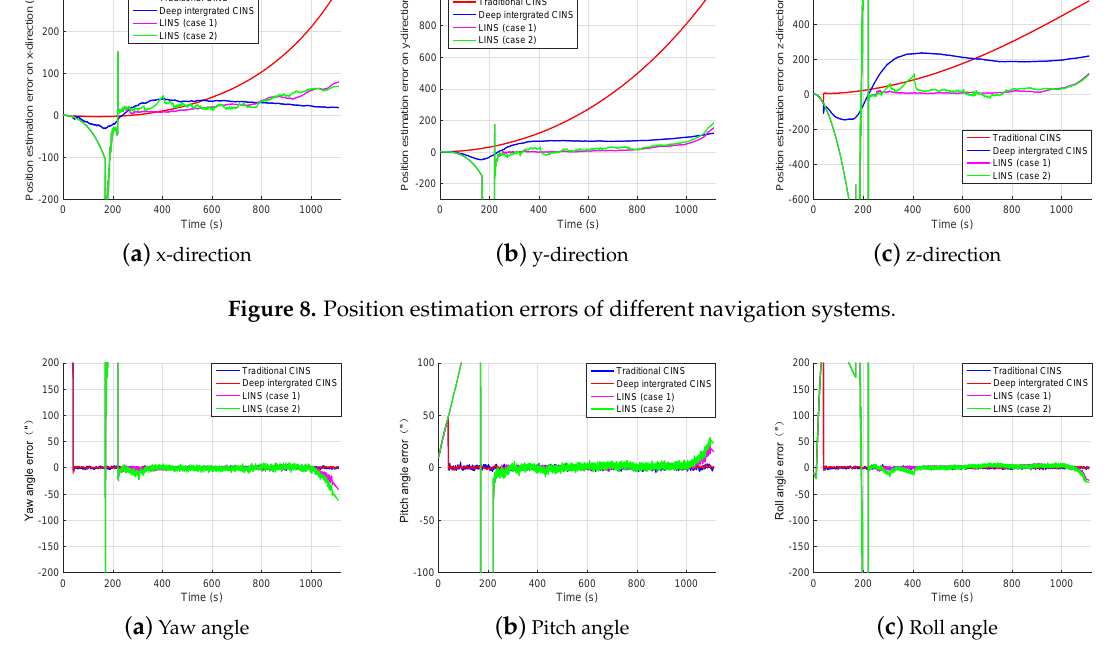
Figure 9. Attitude estimation errors of different navigation